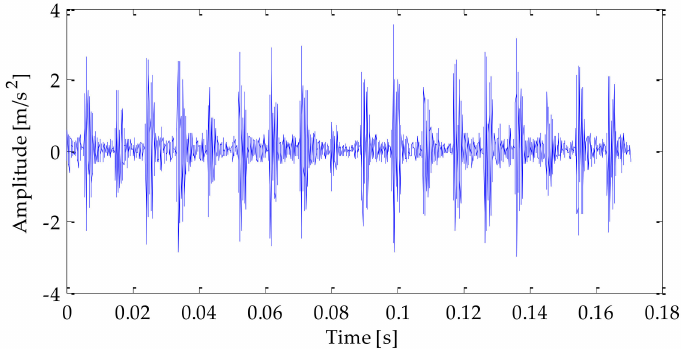
Figure 33. Time domain analysis of the outer ring fault signal.